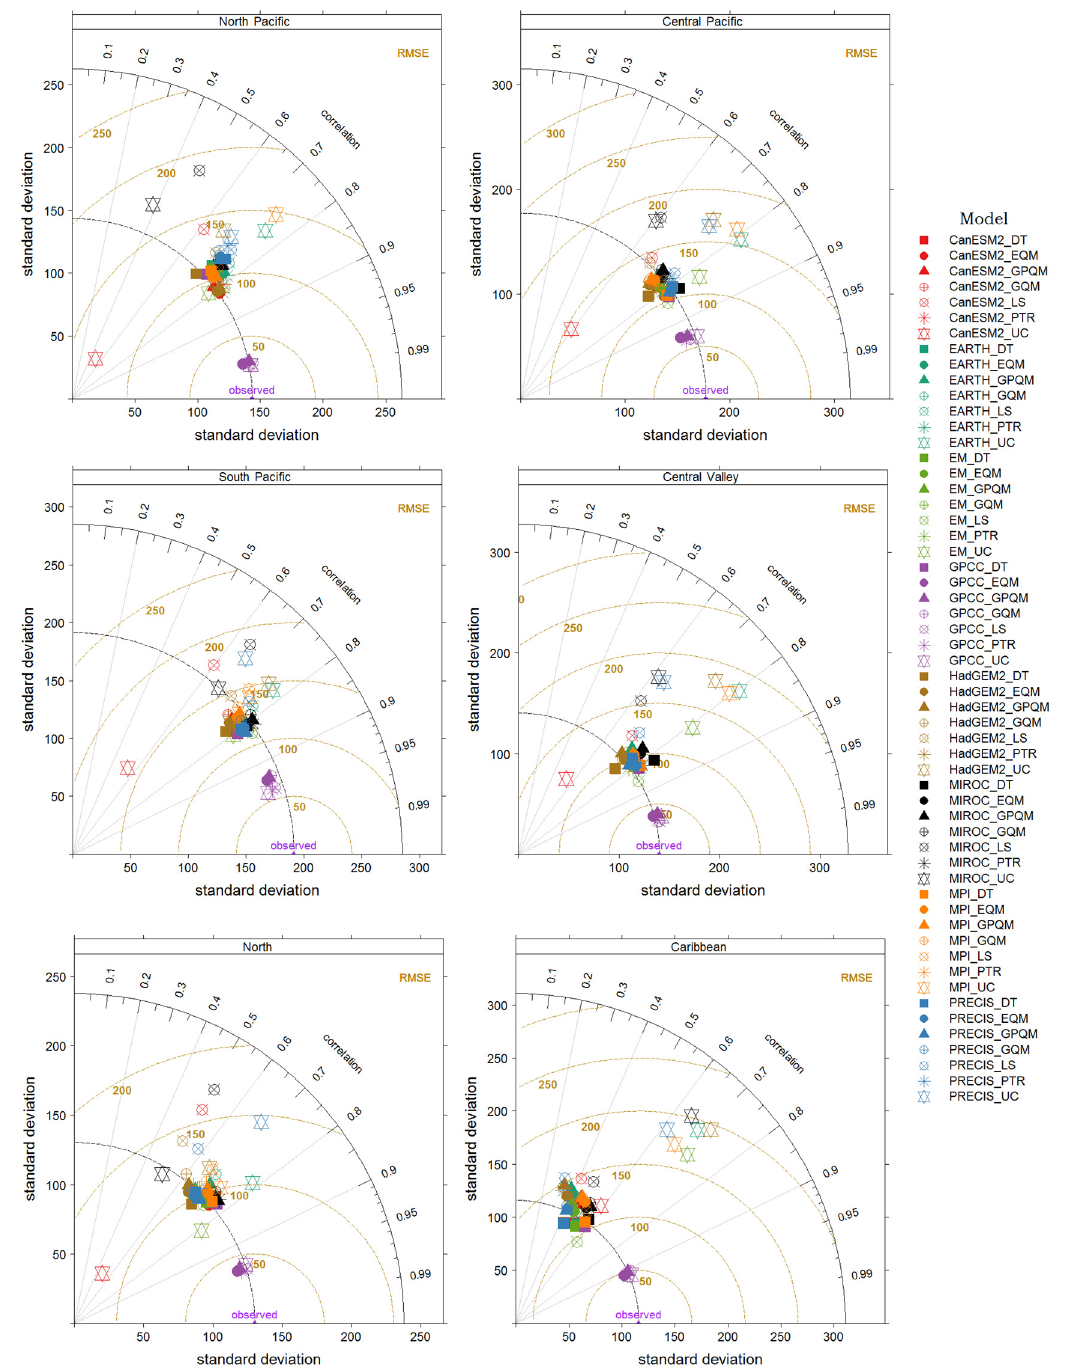
Figure 5. Taylor diagrams of spatially-averaged observed, uncorrected and bias-corrected precipitation during the period 1981–1995 for all climatic regions of Costa Rica.